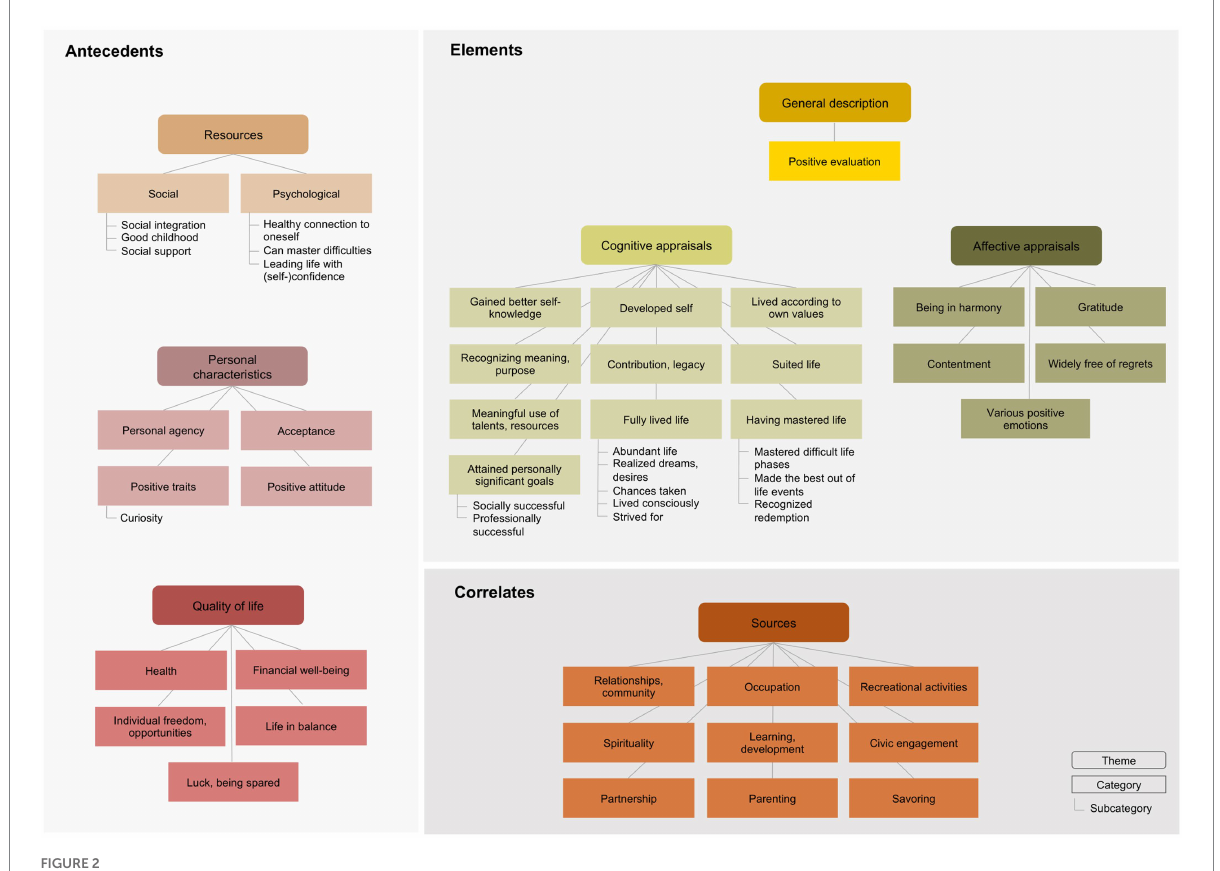
FIGURE 2 Overarching model of a fulfilled life from lay